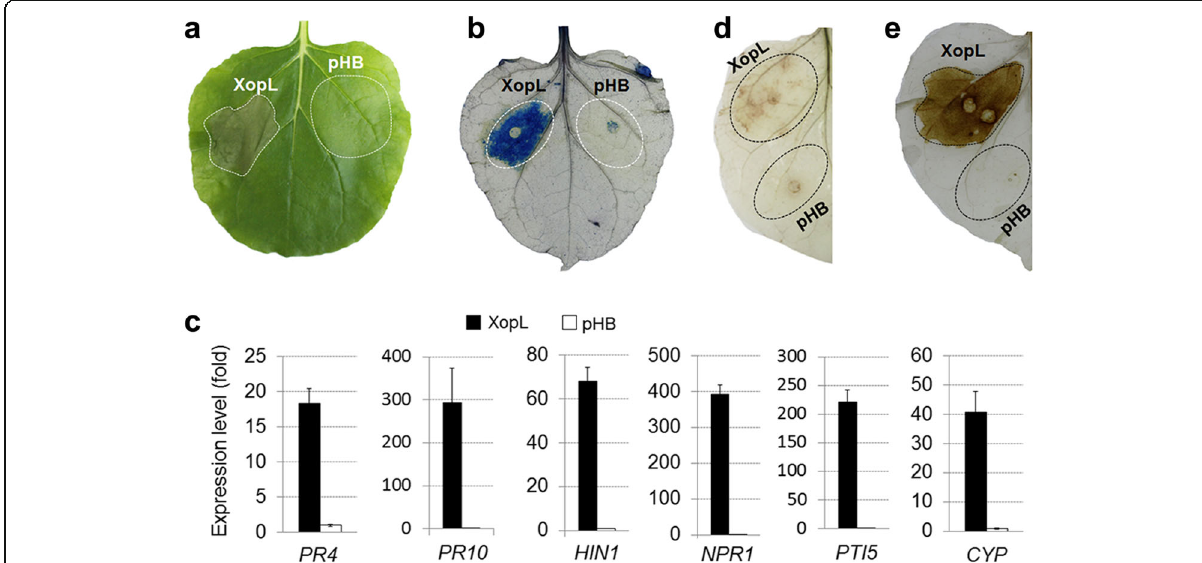
Fig. 2 Analysis of cell death and defense responses in Nb induced by XopL from Xoo . a Phenotype of infiltrated leaves at 7 dpi. Experiments were repeated five times with similar results. b Detection of cell death using Evans blue. The inoculated leaves were stained and photographed at 7 dpi. Picture was representative of three repeats. c Expression of defense-related genes at 4 dpi in Nb plants transformed with pHB-xopL or empty pHB. Mean values ± SD ( n = 3) are shown. Results are representative of three independent replicates. d, e Detection of ROS (H 2 O 2 ) accumulation at 3 and 6 dpi, respectively, using diaminobenzidine (DAB) staining. Experiments were performed three times with the same